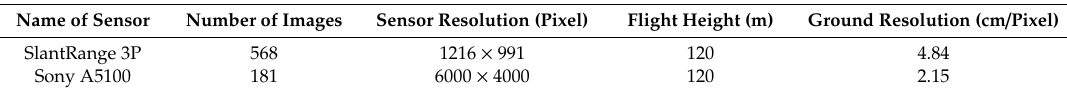
Table 2. The number of raw images and spatial resolution acquired using a suite of sensors attached to the unmanned aircraft system